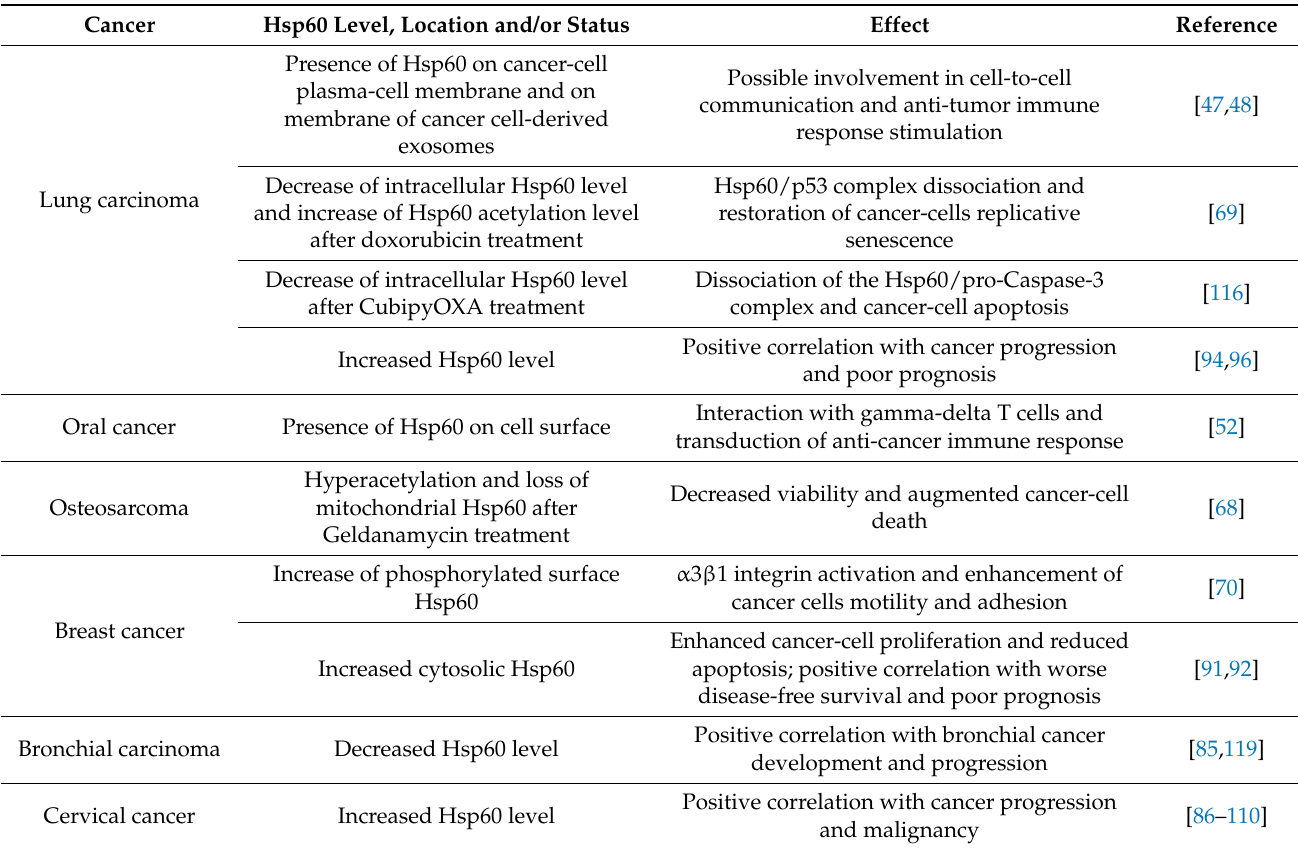
Table 2. Hsp60 in human